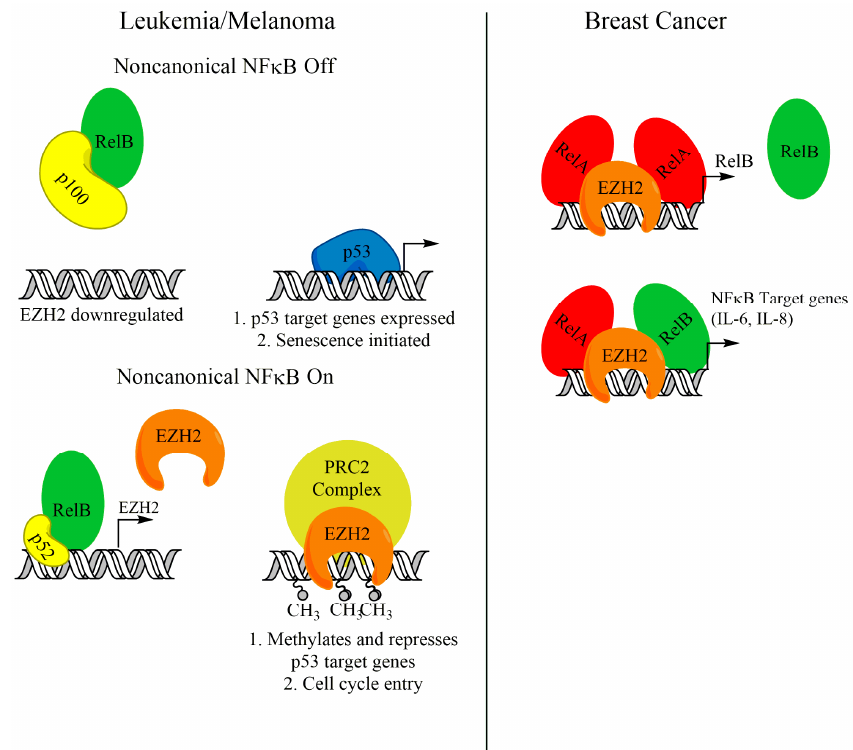
Figure 3. Crosstalk between EZH2 and noncanonical NF- κ B components in CLL, melanoma, and breast cancer. Work in CLL and melanoma shows that RelB-p52 dimers can promote the transcription of EZH2. EZH2 can then promote a senescence bypass by repressing p53 target genes.